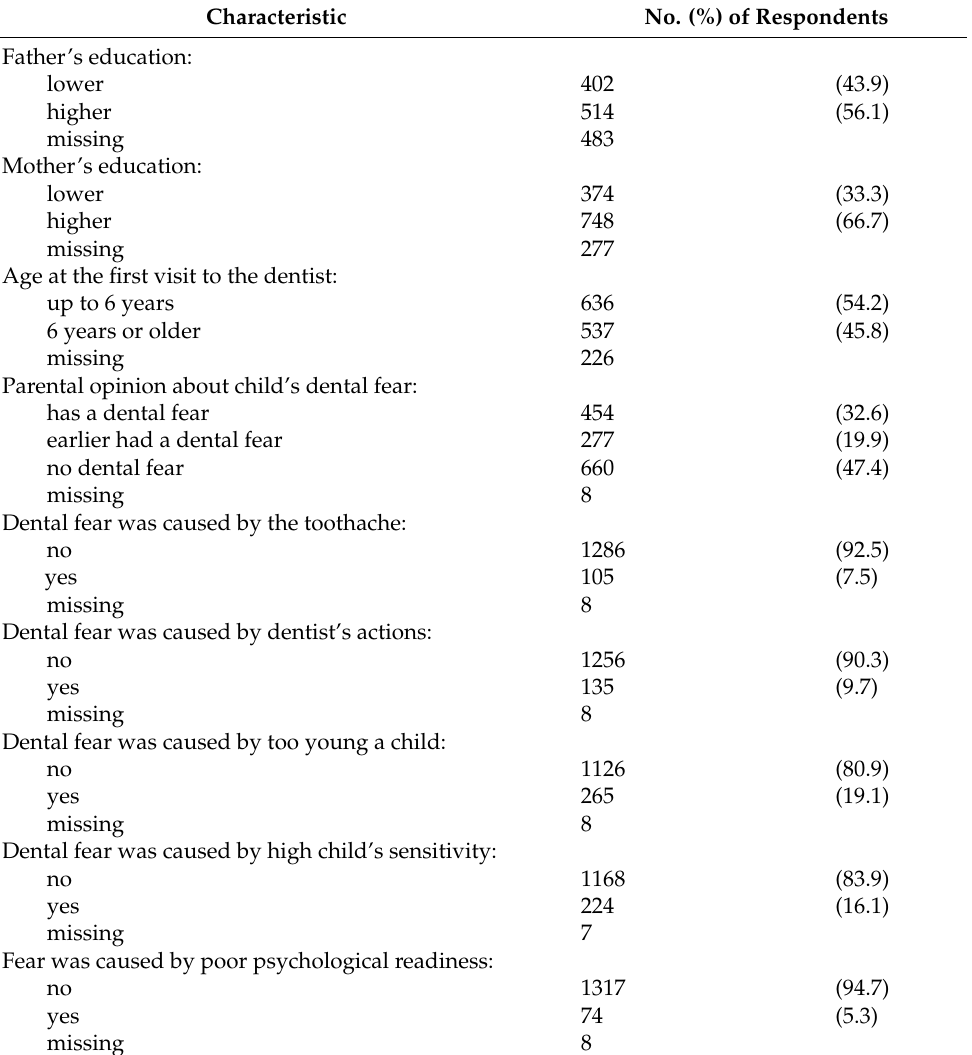
Table 3. Sample characteristics reported by the students’ parents ( n =